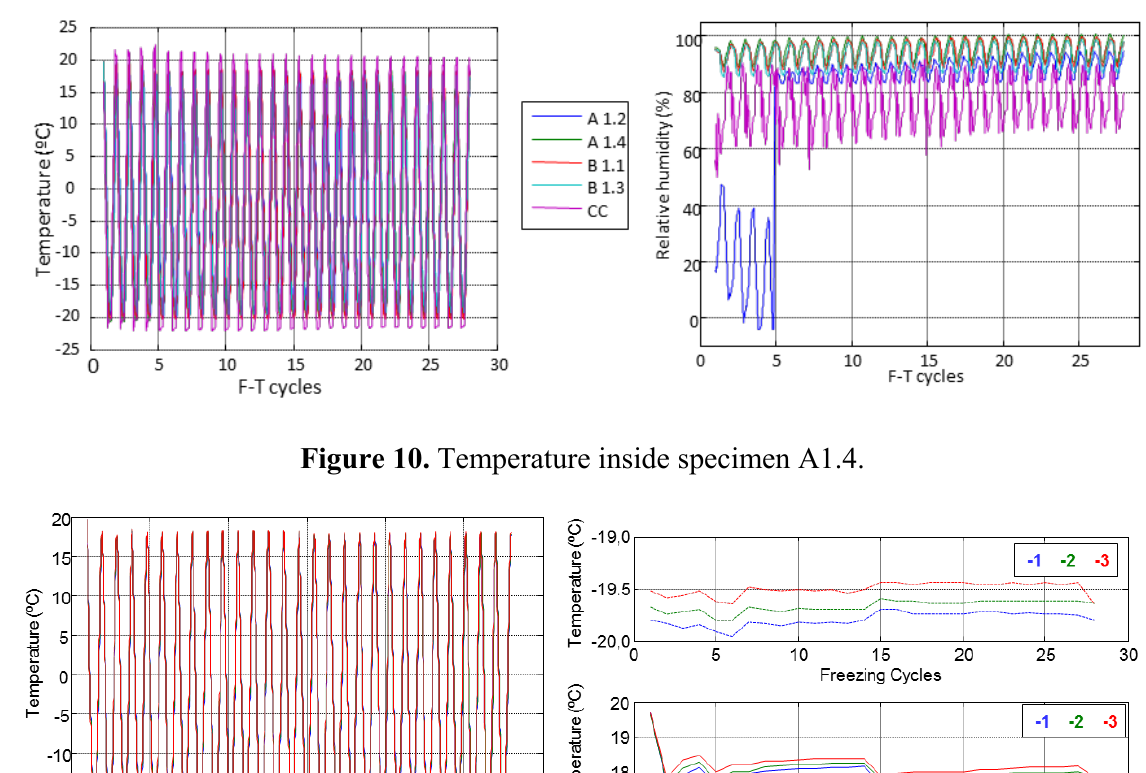
Figure 9. Temperature and relative humidity along cycles.